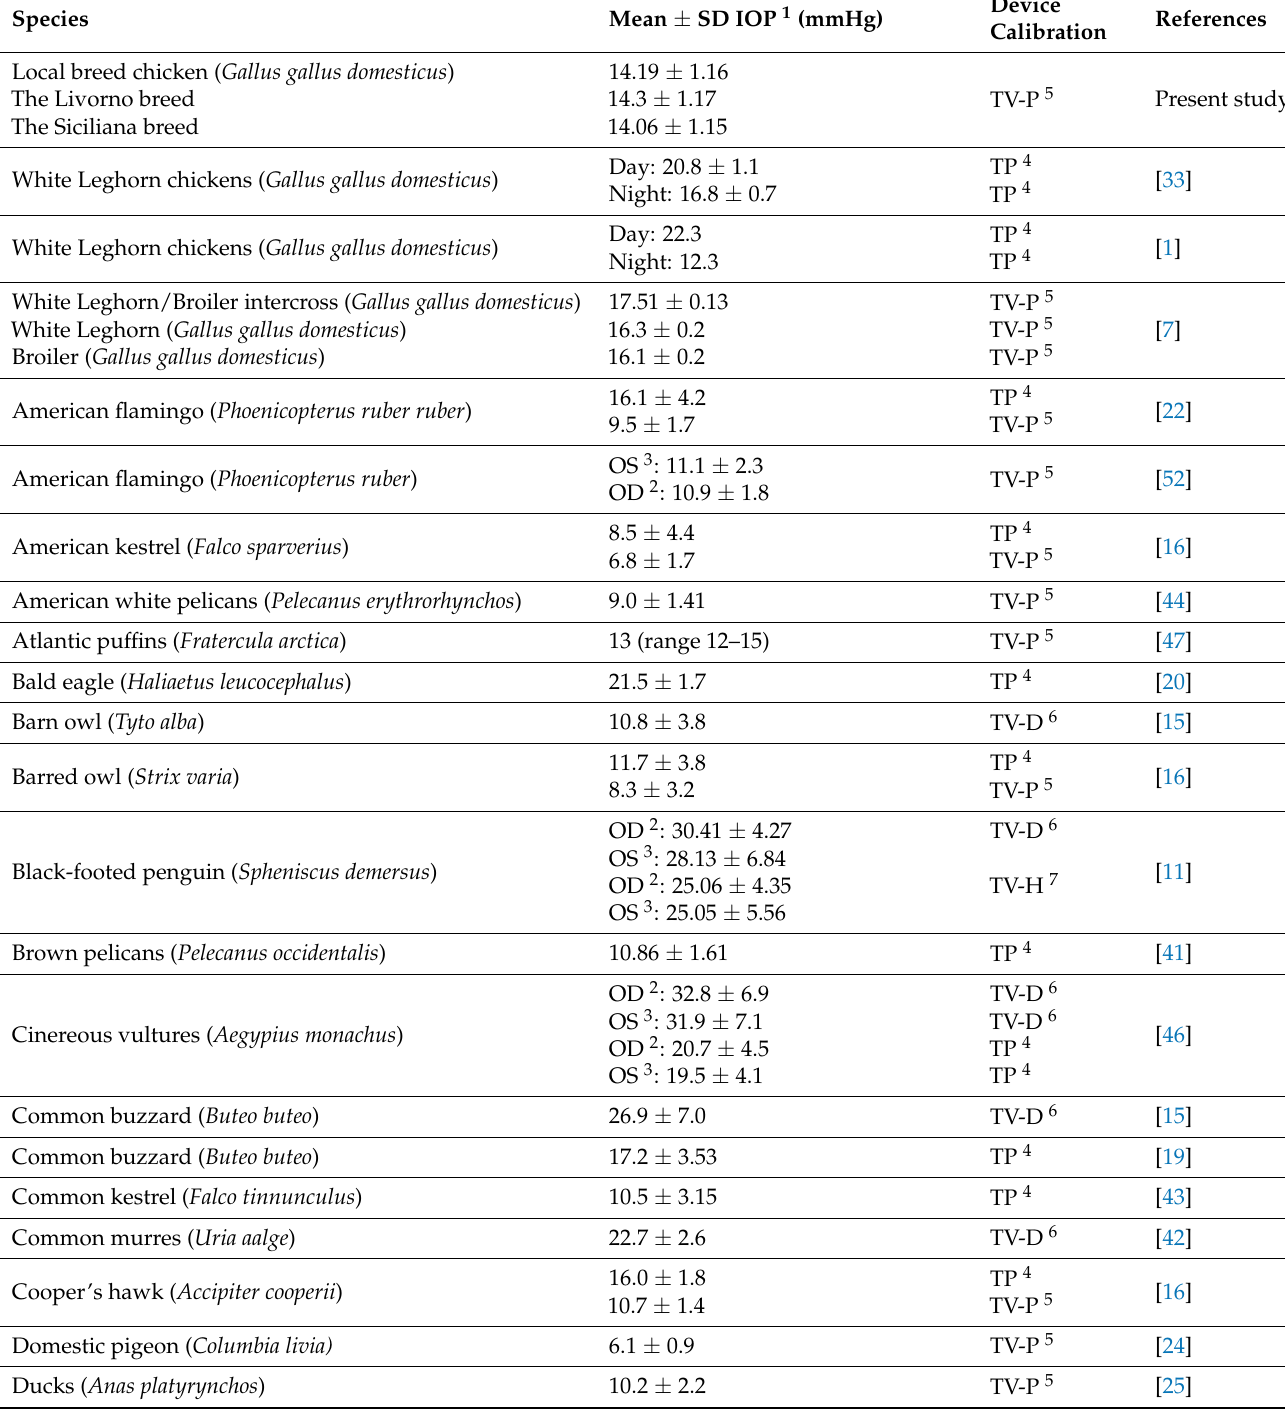
Table 6. Normal values for intraocular pressure (IOP) reported in various avian